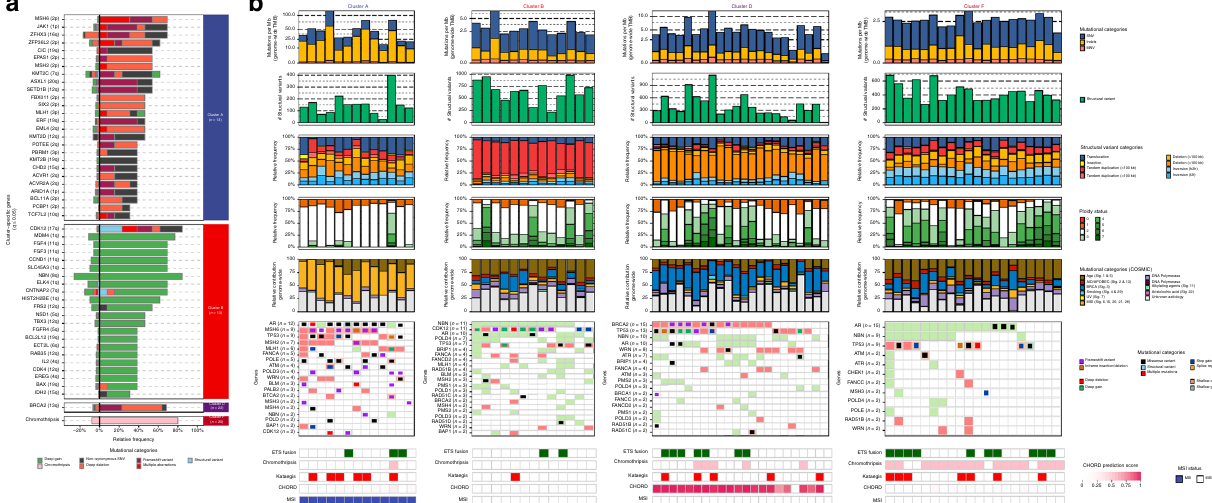
Fig. 6 Distinct genomic phenotypes in mCRPC are enriched by mutually exclusive aberrations in key pathways. a Cluster-speci fi c enrichment of mutated genes (multiple colors), chromothripsis (light pink), and structural variants (light blue) (Fisher ’ s Exact Test with BH correction; q ≤ 0.05). Percentages to the left of the black line represent the relative mutational frequency in mCRPC samples, which are not present in the respective cluster, while the percentages to the right of the black line represent the relative mutational frequency present in the samples from the tested cluster. b Genomic overview with biologically relevant genes in the clusters A, B, D, and F with mutational enrichment of genes or large-scale events. The fi rst track represents the number of genomic mutations per Mbp (TMB) per SNV (blue), InDels (yellow), and MNV (orange) category genome-wide (square-root scale). The second track represents the absolute number of unique structural variants (green) per sample. The third track represents the relative frequency per structural variant category. Tandem duplications and deletions are subdivided into >100 kbp and <100 kbp categories. The fourth track represents relative genome-wide ploidy status, ranging from 0 to ≥ 7 copies. The fi fth track represents the relative contribution to mutational signatures (COSMIC) summarized per proposed etiology. The sixth track displays somatic mutations in the relevant genes found in at least one cluster. The lower tracks represent presence of ETS fusions (green), chromothripsis (pink), kataegis (red), CHORD prediction scores (HR-de fi ciency) (pink gradient), and MSI status (blue) based on a threshold of MSI